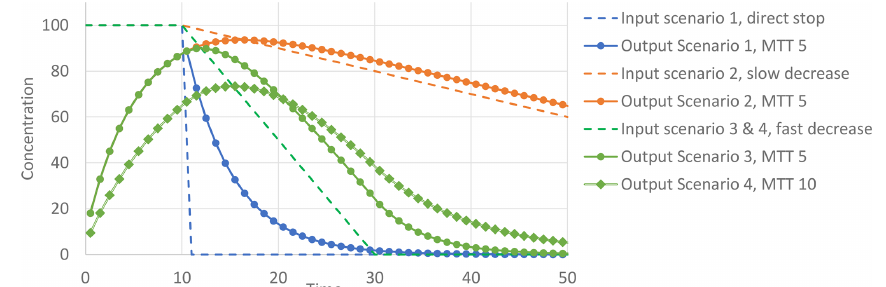
Figure 8. Output concentrations for a hypothetical catchment with an exponential TTD and a MTT of 5 or 10, following three input scenarios, i.e. a direct stop of the input, a slow decrease in the input (decrease of 1% in the maximum per time step), and a fast decrease in the input (decrease of 5% in the maximum per time